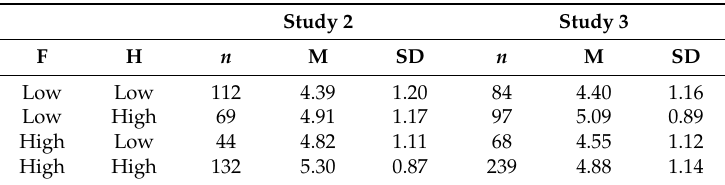
Table 11. Means of Public Value of Employing Organization for Groups with High and Low Levels of Foxiness and Hedgehogness. Study 2 Study